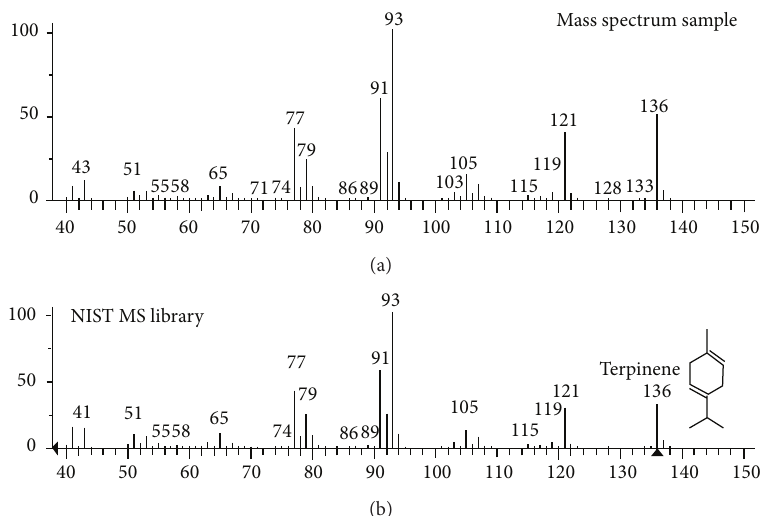
Figure 3: Mass spectrum for 𝜏 -terpinene obtained from the volatile fraction of the oil by SPME fiber PDMS/DVB and compared to the spectrum of the NIST MS library. Retention time 12.57